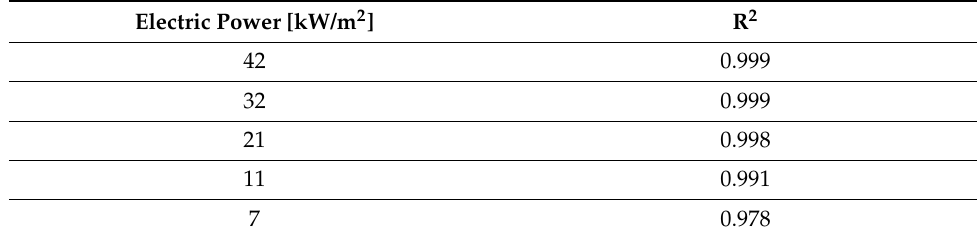
Figure 7. Time trace of temperature with 1.0 m/s and heating for the first 0.2 s in reference to the heating power. Table 3. R 2 value per power to fiber.